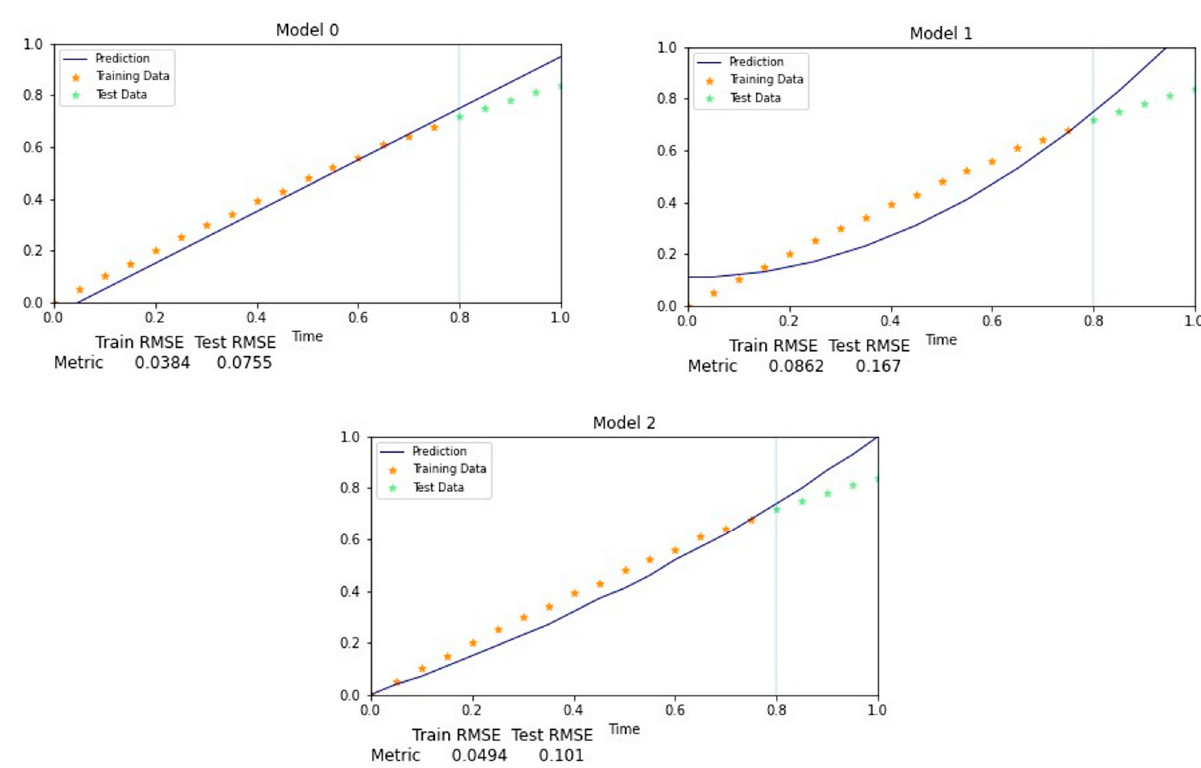
Figure 2. Three models showing different results on generic training and test data.